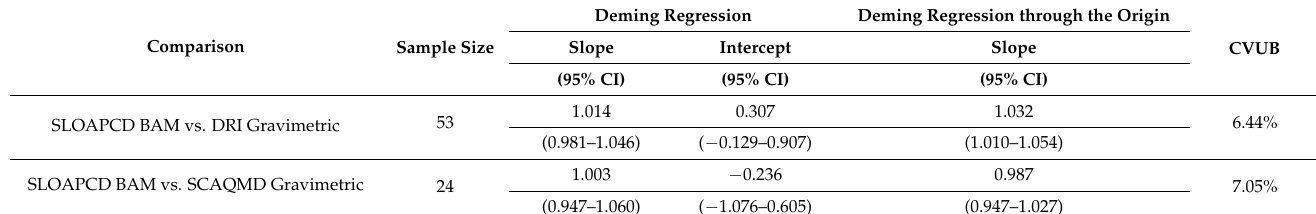
BAM vs. gravimetric PM 10 concentration comparisons—Deming regression and CVUB